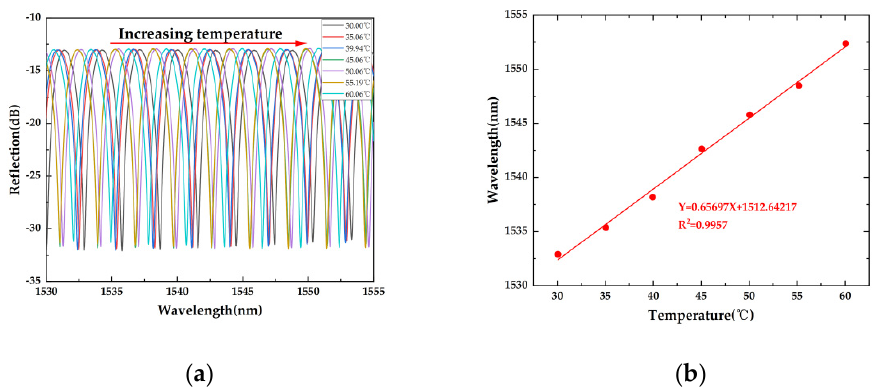
Figure 7. ( a ) Reflection spectrum against temperature of the sensor; ( b ) relationship between the temperature and wavelength shift.